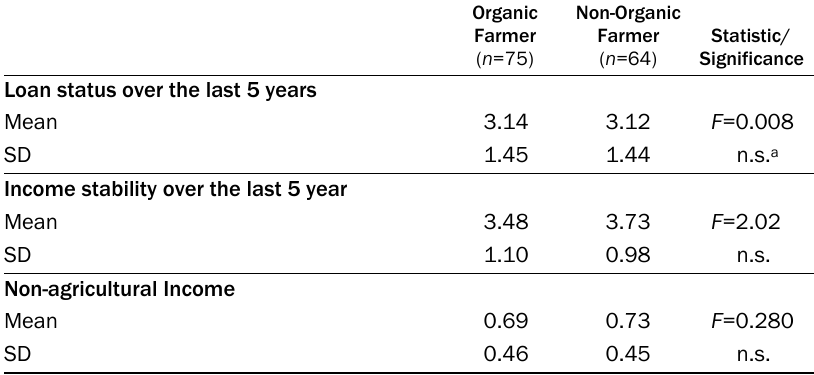
Table 7. Differences Between the Financial Views of Organic and Non-Organic Farmers